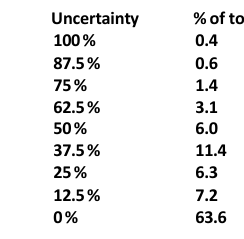
Figure 5. Spatial rescaling issues. The blue area represents ocean and the green area represents land. A hypothetical rescaling from 1 to 5km is shown. Note that cell C in the finer scale resolution has been recoded to ocean in the coarser resolution. In rescaling FFCO2 mass maps, this recoding is often accompanied by the movement of FFCO2 from cell C to cell D.